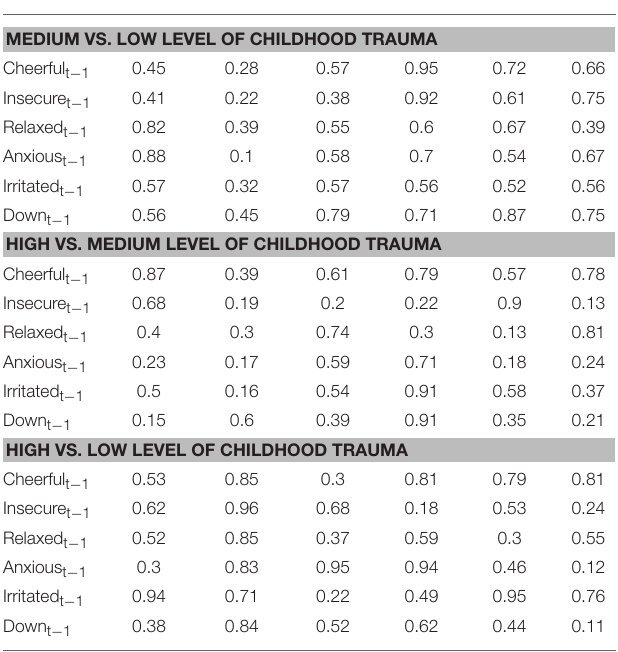
TABLE 2 | Comparison between regression coefficients in the different childhood trauma strata ( p -values presented were obtained from permutation tests of between group differences, Simes corrected alpha =